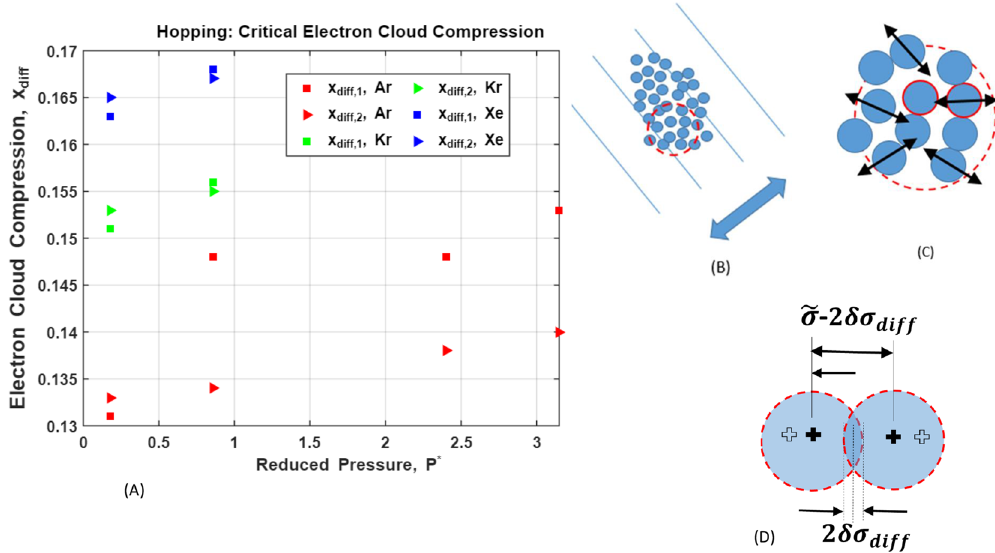
Figure 6. Two observations 63,65 provide important clues concerning the mechanism driving self-diffusion in liquids: (i) 65 shows that at any instant, a significant fraction of interacting molecular pairs in liquid Ar exist in a state of mutual repulsion, while in the corresponding solid, only a small fraction of pairs are in such states. (ii) The velocity autocorrelation function (VACF) in Lennard–Jones liquids, e.g., noble liquids, is largely determined by the repulsive part of the potential 63 . Viewed in terms of the proposed phonon models of self-diffusion, and given the dominance of pair-wise collisions, these observations suggest that the relatively large single-molecule kinetic energies required for hopping are supplied by collisional compression of adjacent electron clouds. 2 1 / 6 σ is the δσ diff ,1,2 / σ , are estimated relative compressions of individual clouds, and σ Here, x diff ,1,2 = ˜ ˜ = as a short discussion of the gap between compression estimates observed for Ar. In order to contrast liquid state phonon modes, whose wavelengths are all smaller than or approximately equal to 2 σ/ 3, with collective, , ( B ) depicts a (short-wavelength, standing) sound ] wave (blue double arrow). Panel ( C ) depicts the jitter-like phonon oscillations that are superposed on slower hydrodynamic modes. Panel ( D ) depicts the electron cloud compression driving